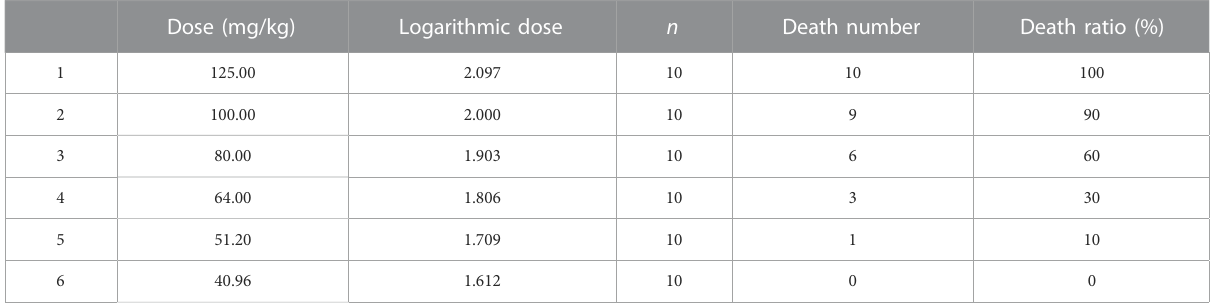
TABLE 1 LD50 value of HAS in mice. Dose